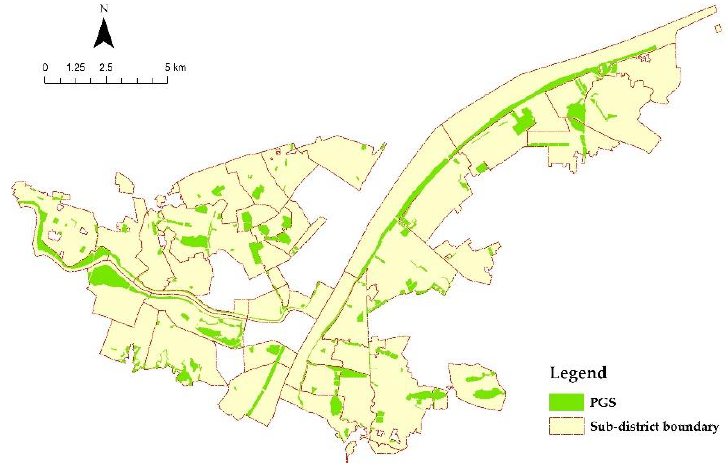
Figure 4. Distribution of PGS (with an area of more than 1ha).